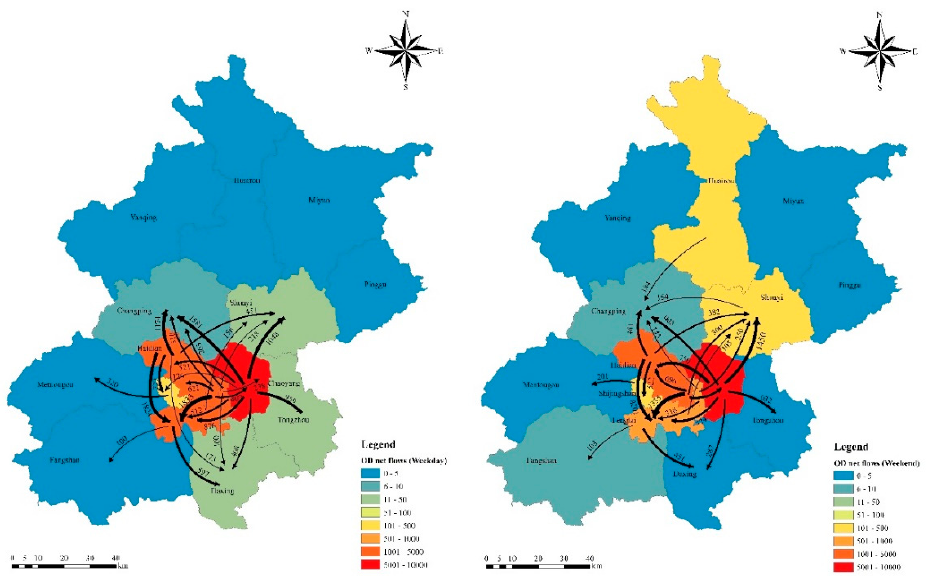
Figure 14. Distribution of OD net flows in various regions of Beijing.